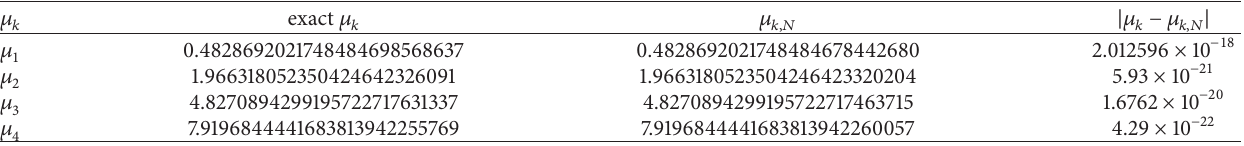
Table 6: The approximation 𝜇 𝑘,𝑁 and the exact solution 𝜇 𝑘 for 𝑁 = 40 , 𝑚 = 14 and 𝜃 = 1/26 .